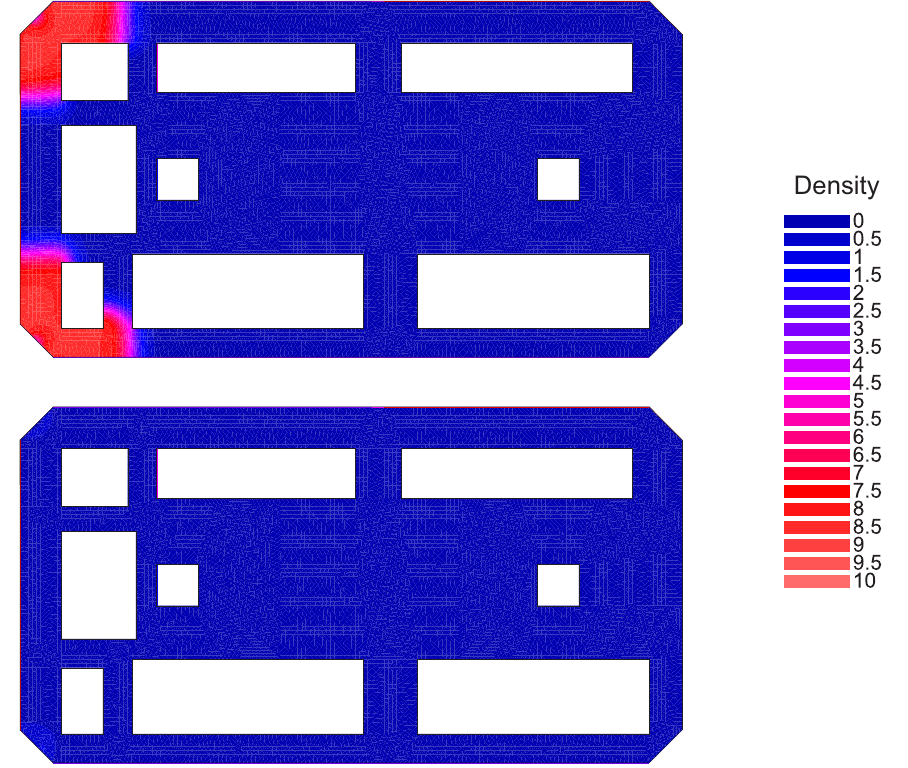
Figure 6. Case 1: Pedestrian densities ρ at final time t = 350 for the initial ( top ) and the optimal locations ( bottom